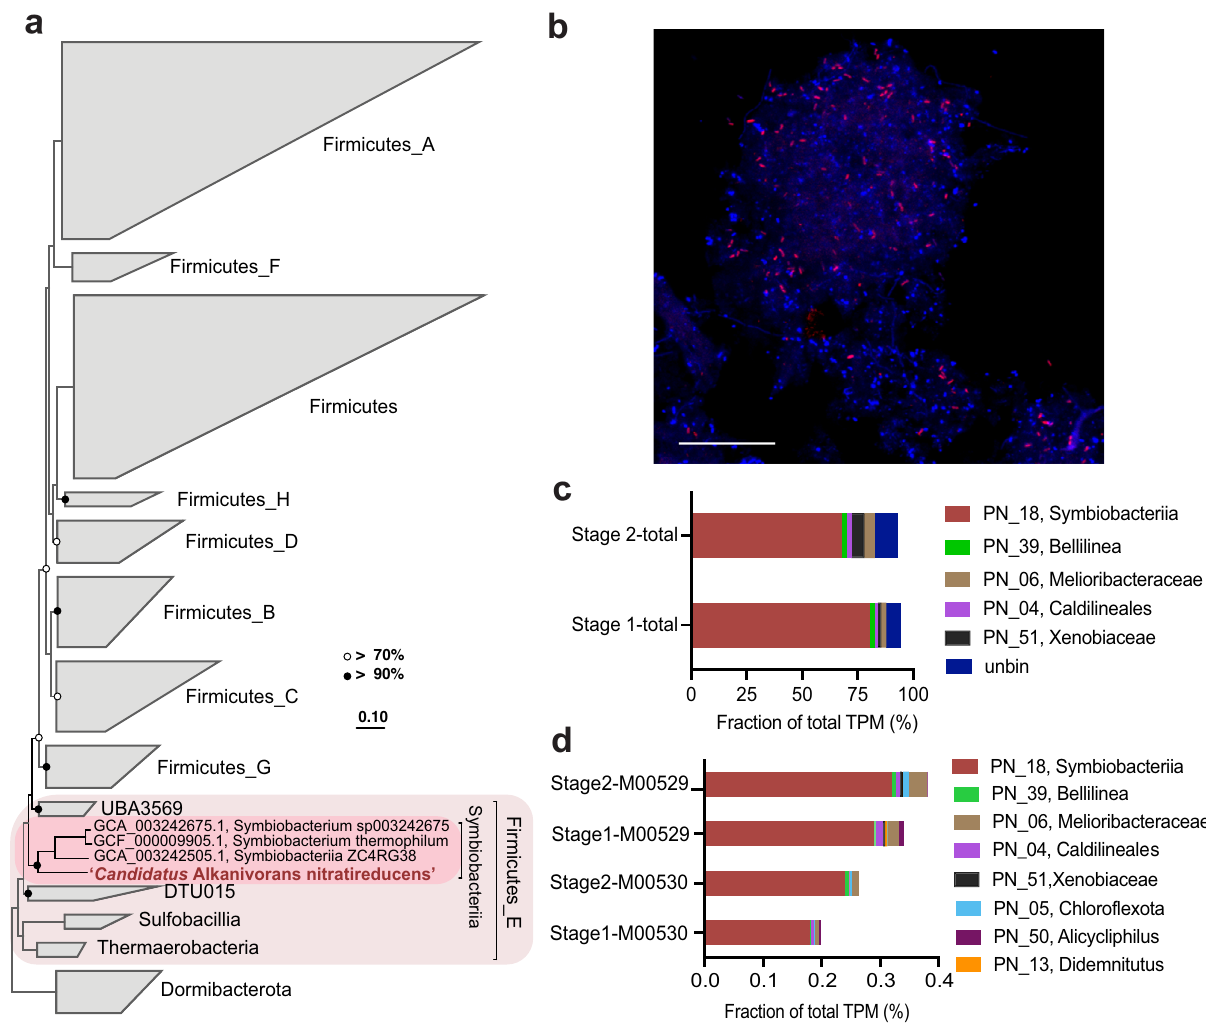
Fig. 3 | Phylogenetic af fi liation and a fl uorescent micrograph of ‘ Ca . A. nitra- tireducens ’ , and relative gene expression pro fi les for the enrichment